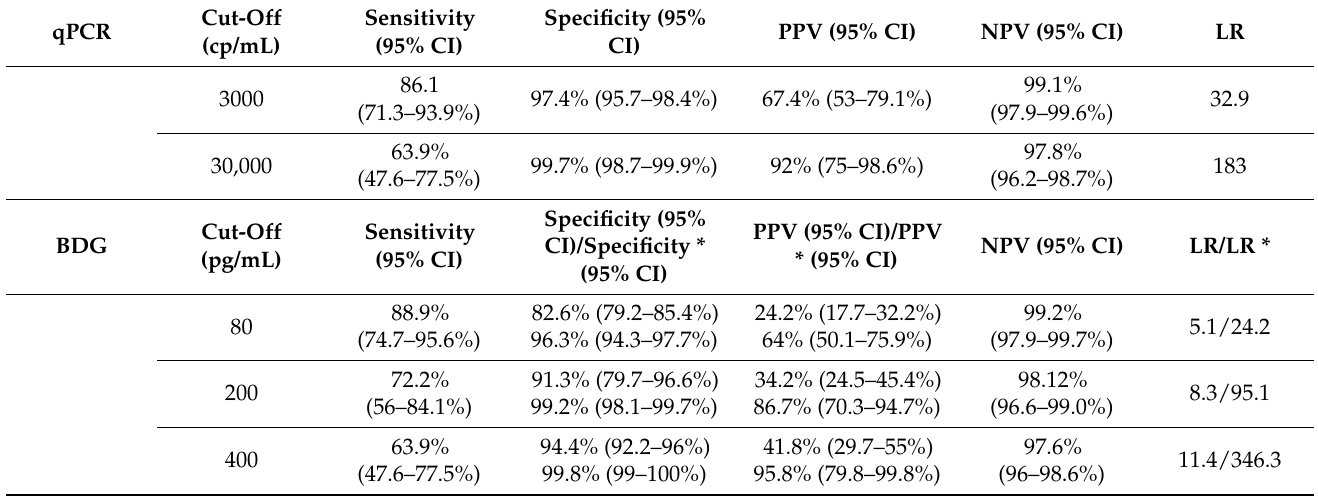
Table 2. Performances of BDG assay and molecular diagnosis as a screening strategy for the diagnosis of PjP in 609 episodes occurring in 575 HIV-negative patients.